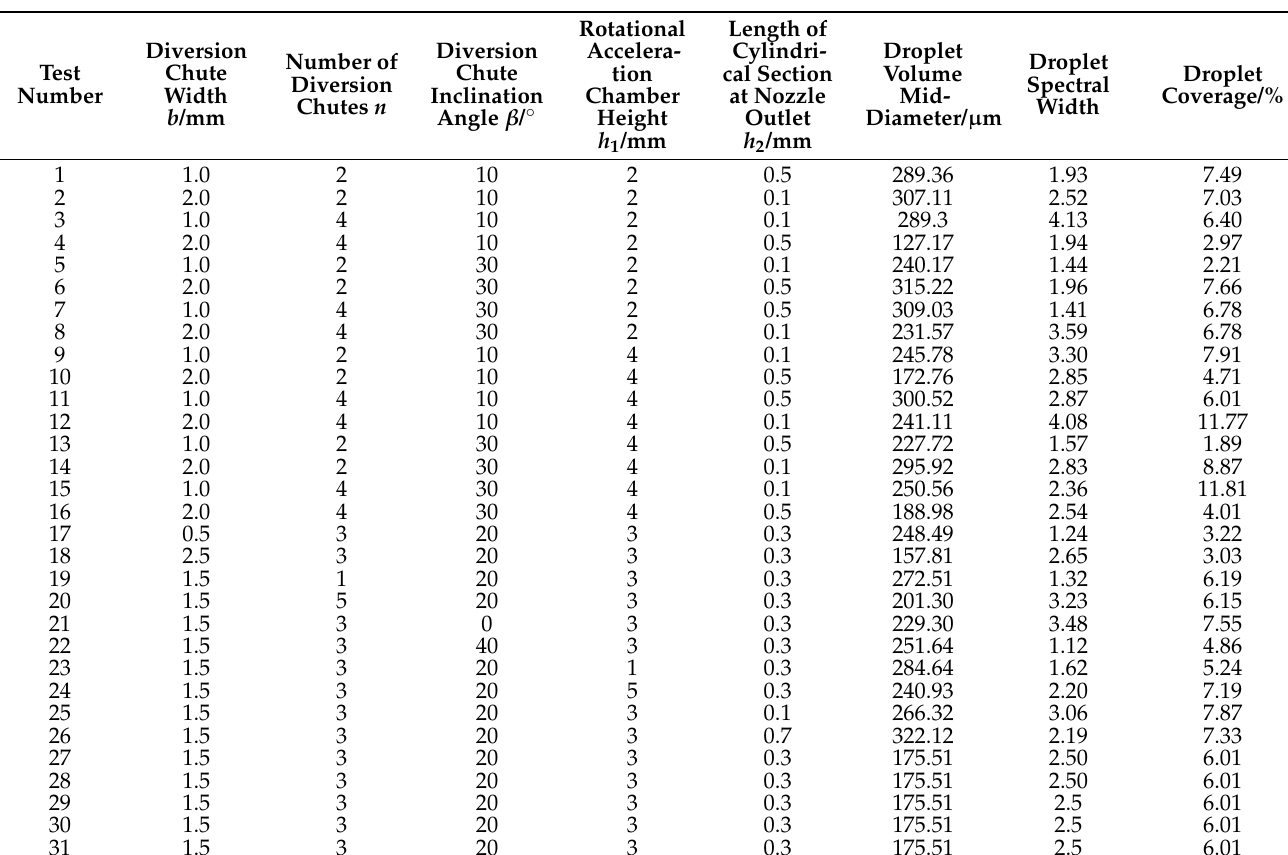
Table 3. The results of spraying pesticide